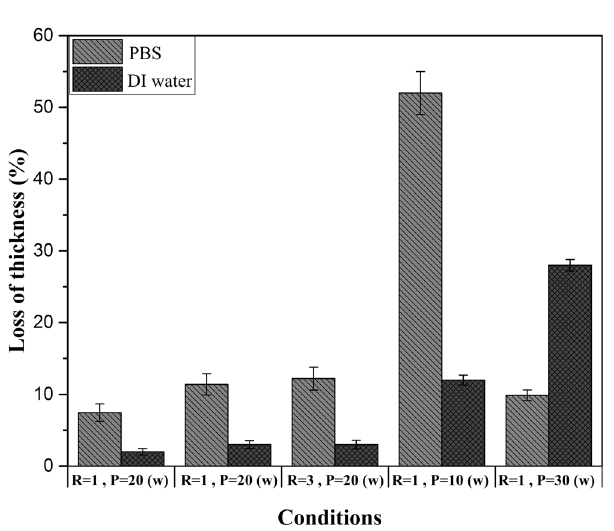
Figure 8. Solubility of deposits, or loss of thickness, after immersion in Milli-Q water and PBS in various condition of plasma